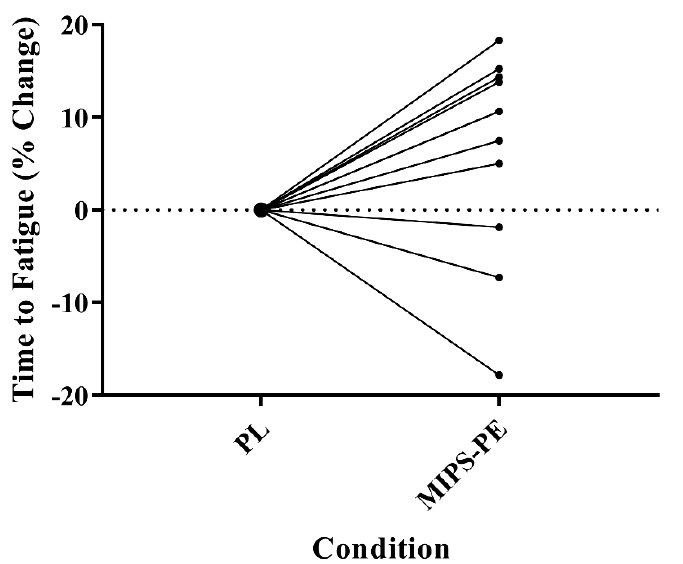
Figure 2. Percent change in time to fatigue in the supplement condition relative to the placebo control. Percent change between the conditions was calculated as follows: [((Supplement/Placebo) − 1) × 100]. Eight of the eleven subjects (72.7%) experienced an increased TTF in the supplement condition relative to the placebo, with an average increase of 6.2 ± 11.0%.